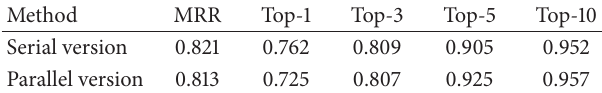
Table 2: Retrieval results for different